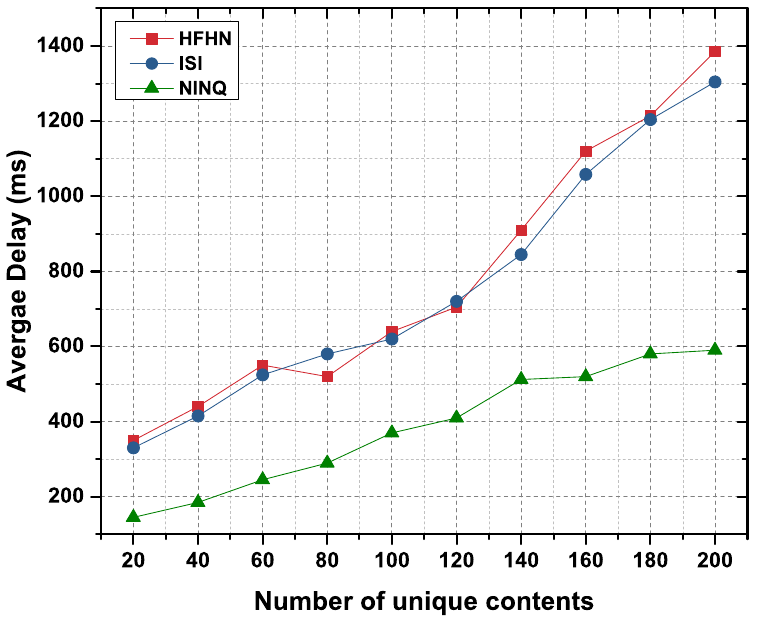
Figure 16. Average delay in a network as function of number of unique contents.